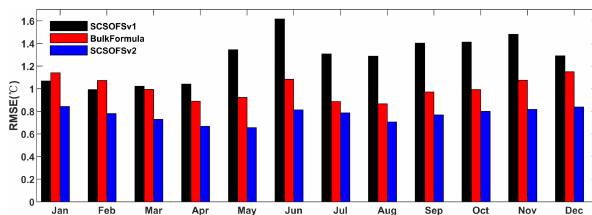
Figure 4. Domain-averaged monthly mean SST RMSE compari- son of the SCSOFSv1 (black), BulkFormula (red), and SCSOFSv2 (blue) with the OSTIA SST in January, April, July, and October of